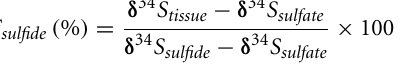
FIGURE 5 | Linear regressions between seagrass tissue total sulfur content (Tissue TS) and tissue δ 34 S in Posidonia oceanica (upper panel) and Zostera marina (lower panel) and leaves (left row), rhizomes (middle